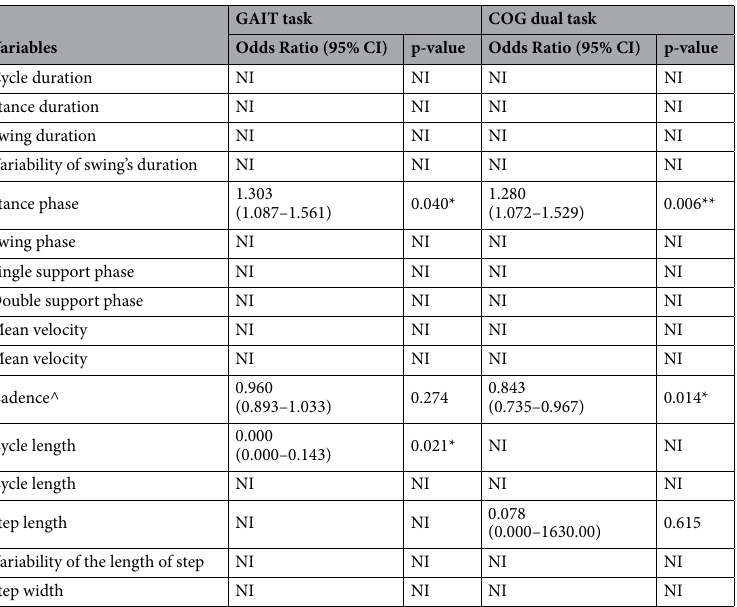
Table 6. Multinomial logistic regression results for GAIT and COG tasks to distinguish newly diagnosed PD and early PSP patients. Odds ratio (95% confidence interval) and p-value for each variable were considered in the model. PD Parkinson’s disease, PSP progressive supranuclear palsy, NI not included. *Significance level at 0.05. **Significance level at 0.01.